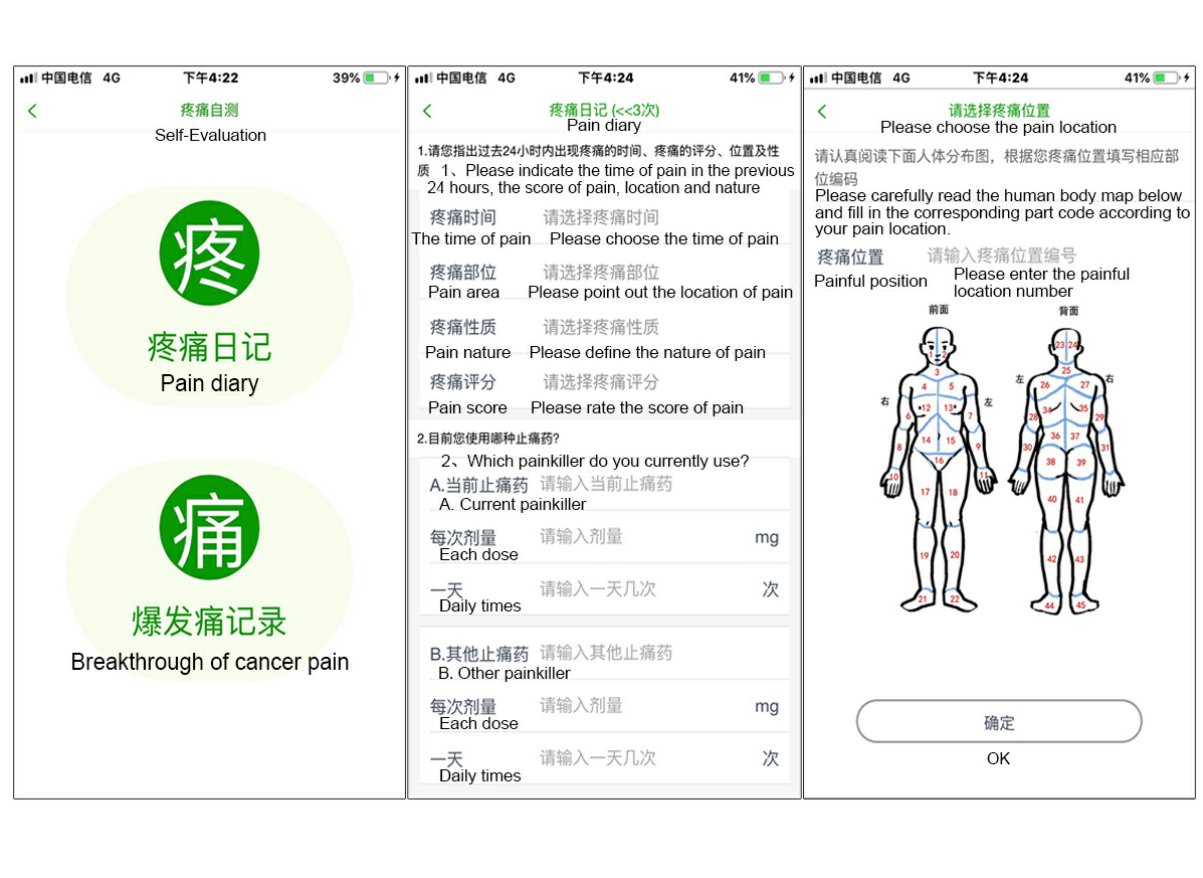
Figure 3. Screenshot of the self-evaluation module, including the pain diary and breakthrough cancer pain assessment